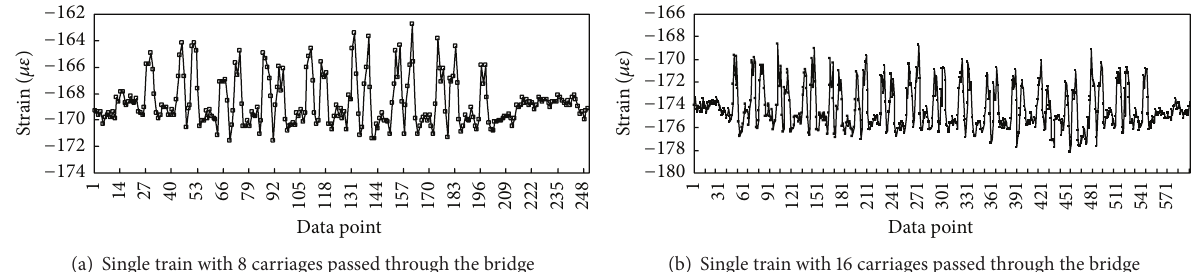
Figure 20: Typical strain time-history curves of DYB-2 when single train passed through the